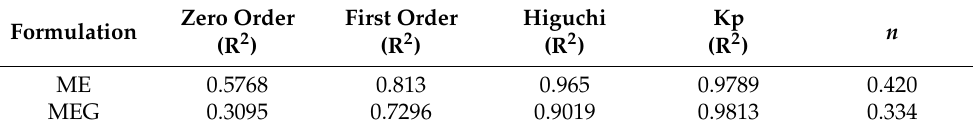
Table 7. Kinetic modeling of release data of microemulsion (ME) and microemulgel (MEG).